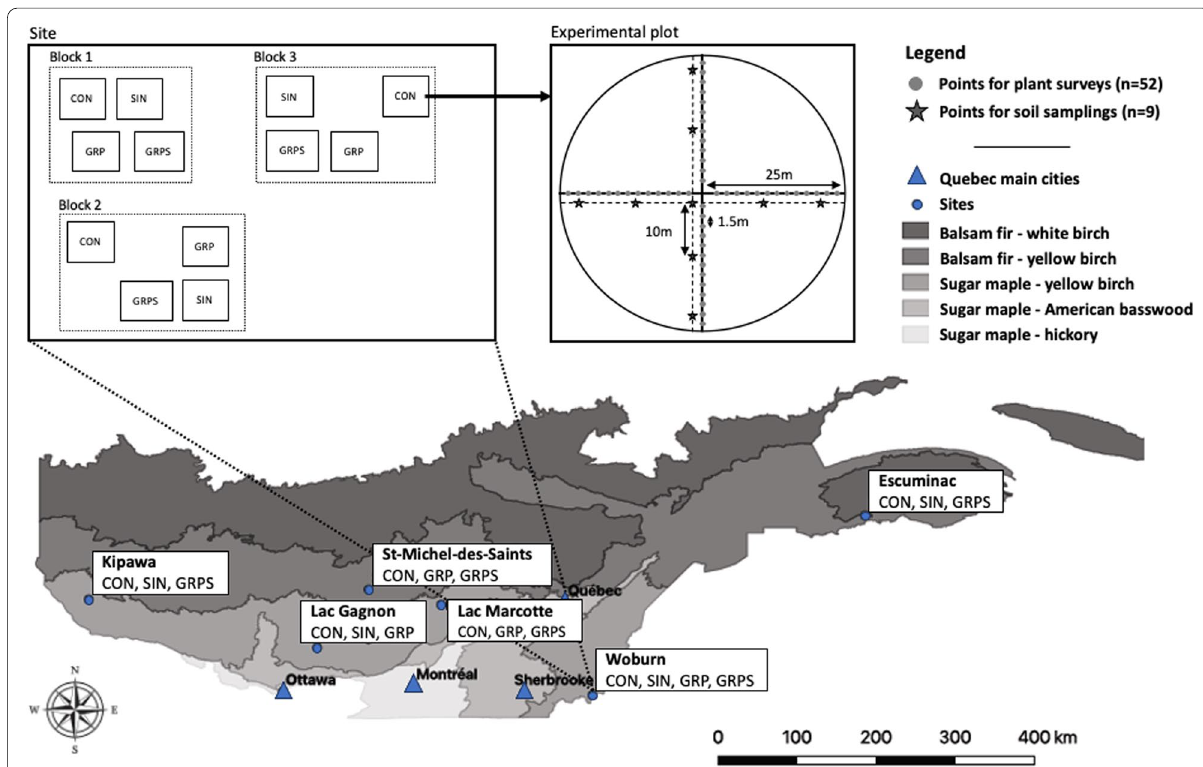
Fig. 1 Geographic location of experimental sites. Information on the bioclimatic domains and silvicultural treatments present in each experimental site. Diagram of the experimental units. The experimental plot has a surface area of 1962.5 m 2 comprising 52 floristic inventory points and 9 soil sampling points distributed along the four inventory transects. CON control, SIN single-tree selection cut, GRP group-selection cut, GRPS group-selection cut with